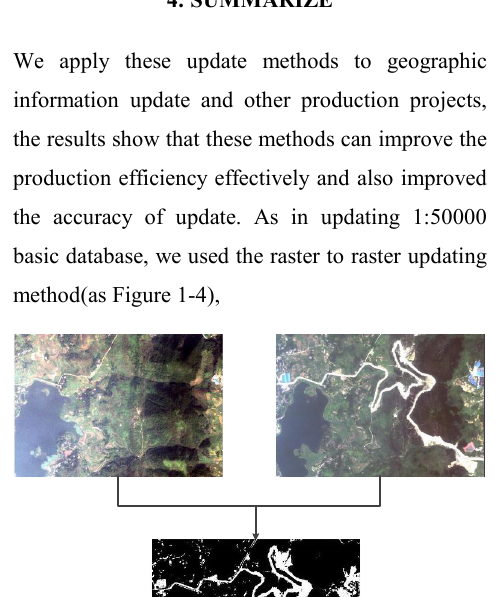
Figure 1-3 Flow chart of update vector data